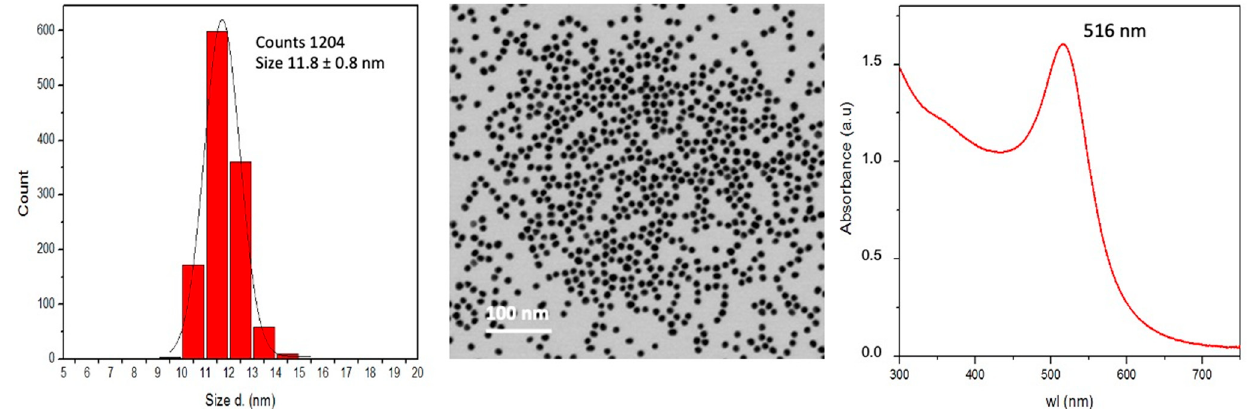
Figure 1. Main characteristics of AuNPs. ( Left ): size distribution by STEM; ( Centre ): STEM image; ( Right ): absorbance peak via UV ‐ VIS.